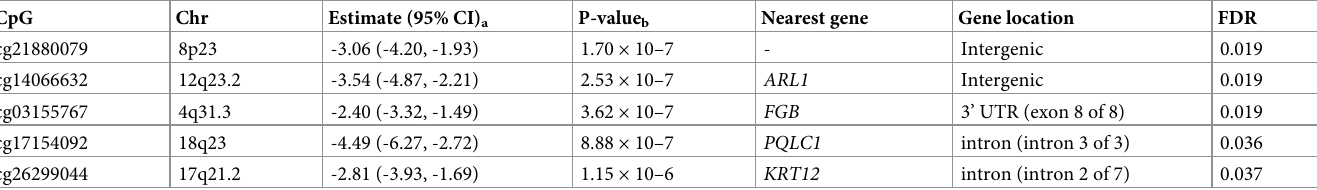
Table 1. Significant CpGs that are different between myopic cases and controls at a 5% FDR. CpG Chr